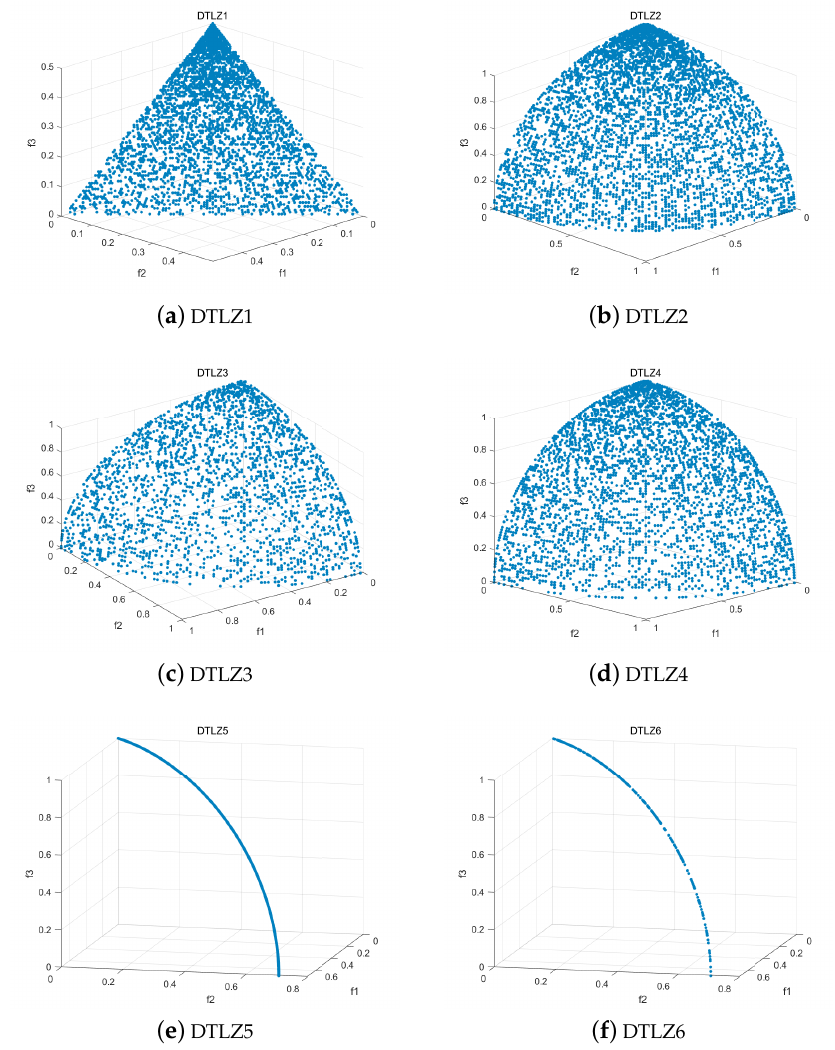
Figure 3. Solutions with INSGA-II on DTLZ test function.